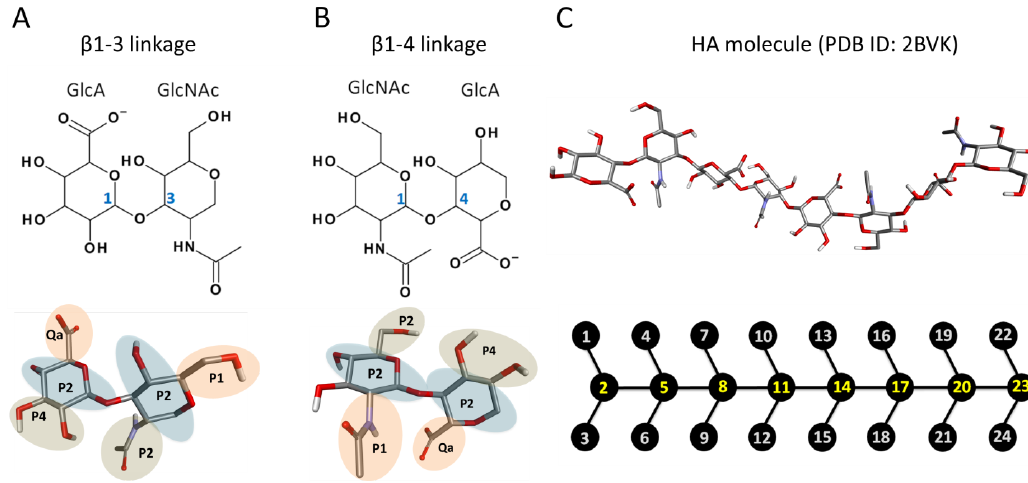
Figure 1. Chemical structures (top) and atomistic visualization (bottom) of HA1-3 and HA1-4 disaccharides ( A ) and ( B ). ( C ) Atomistic representation (top) of octasaccharide hyaluronic acid (HA) and its coarse-grained (CG) representation (bottom).